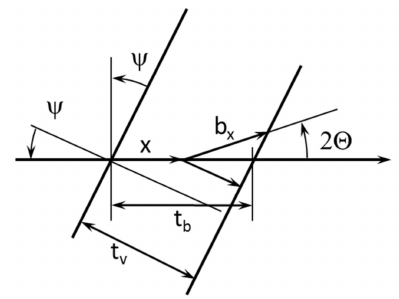
Figure 2. Sketch for the correction of di ff erent beam paths within the sample due to the tilted sample orientation with a tilting angle ψ between incoming beam and sample. Instead of the initial thickness t v of the sample the beam passes the thickness t b , while the path of the scattered beam is x + b x .